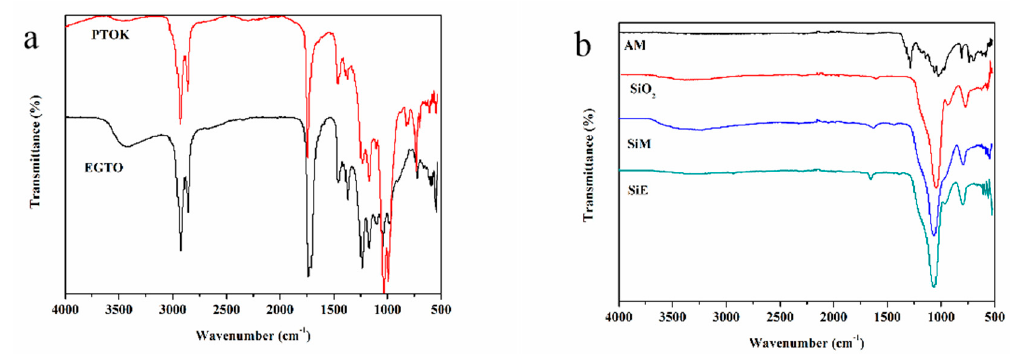
Figure 4. FTIR of PTOK, EGTO ( a ), AM, SiO 2 , SiM, and SiE ( b ).